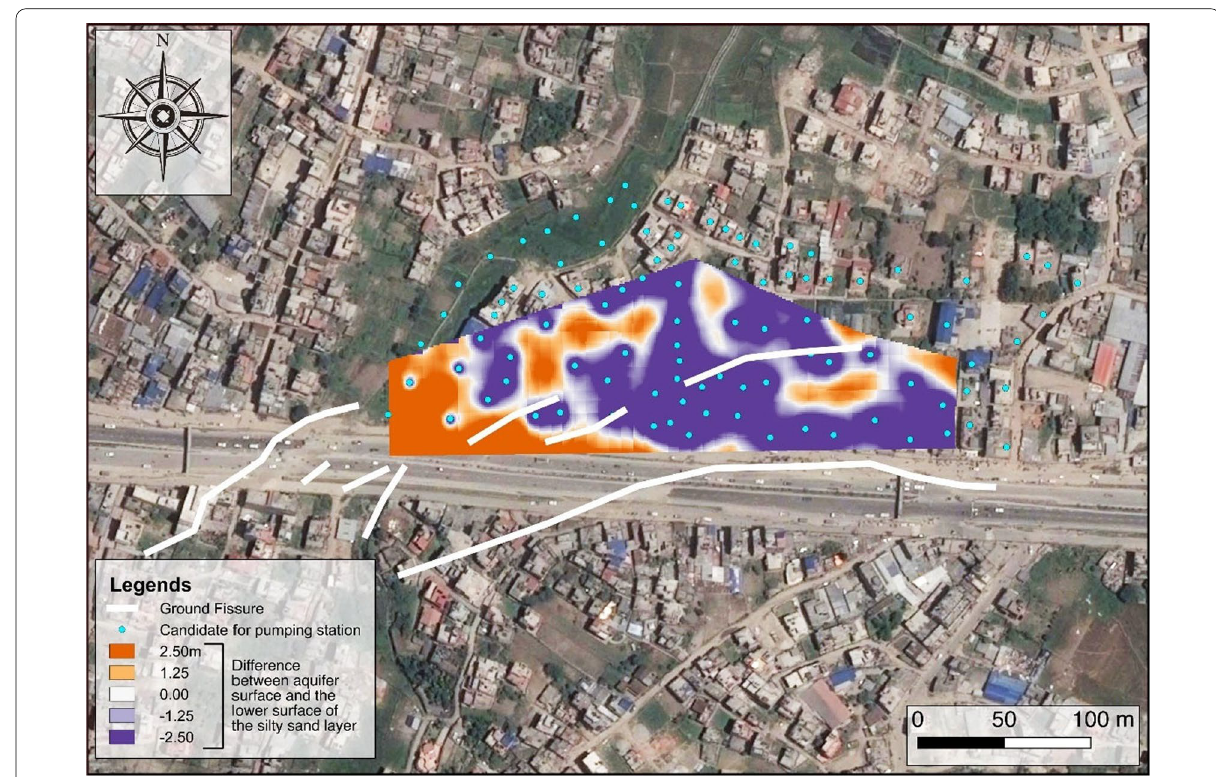
Fig. 10 Difference between the upper surface of the aquifer and the lower surface of the silty sand layer in Kausaltar (After lowering groundwater level)